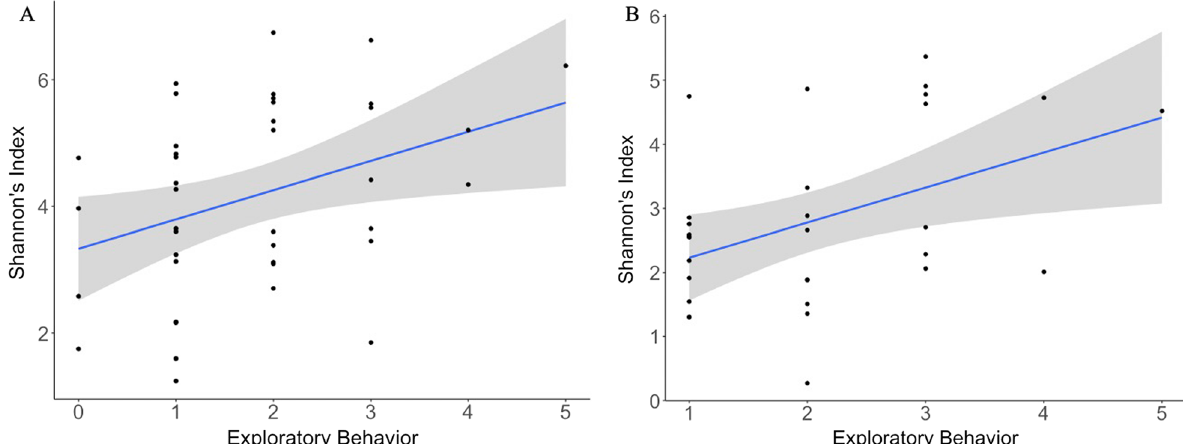
Fig. 1 Relationship between exploratory behavior (number of objects visited) and Shannon diversity index of the gut microbiome of samples collected before ( A ) and after ( B ) captivity